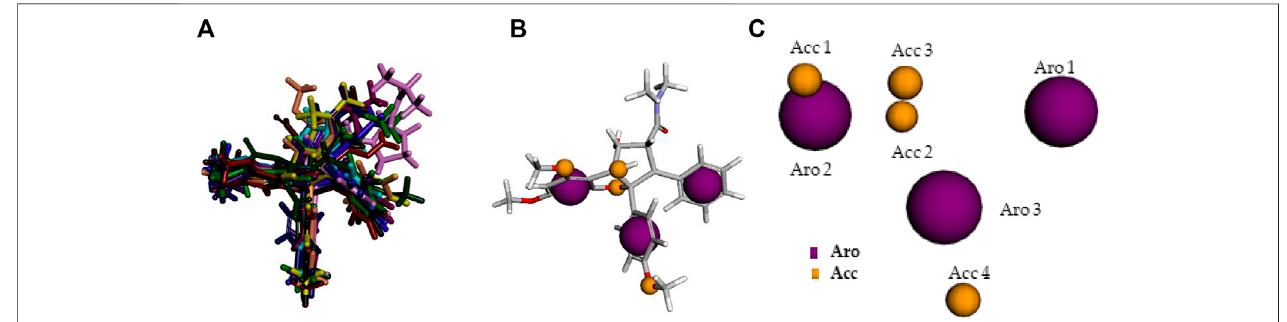
FIGURE6| QualitativecharacteristicsofthebestpharmacophoremodelinitiallygeneratedbyPharmaGist. (A) Alignedmolecules. (B) Pharmacophoricfeaturespositioned over Roc-A (pivot molecule). (C) Pharmacophoric features: 3 aromatic groups (Aro) in purple, and 4 hydrogen bond acceptor groups (Acc) in yellow.